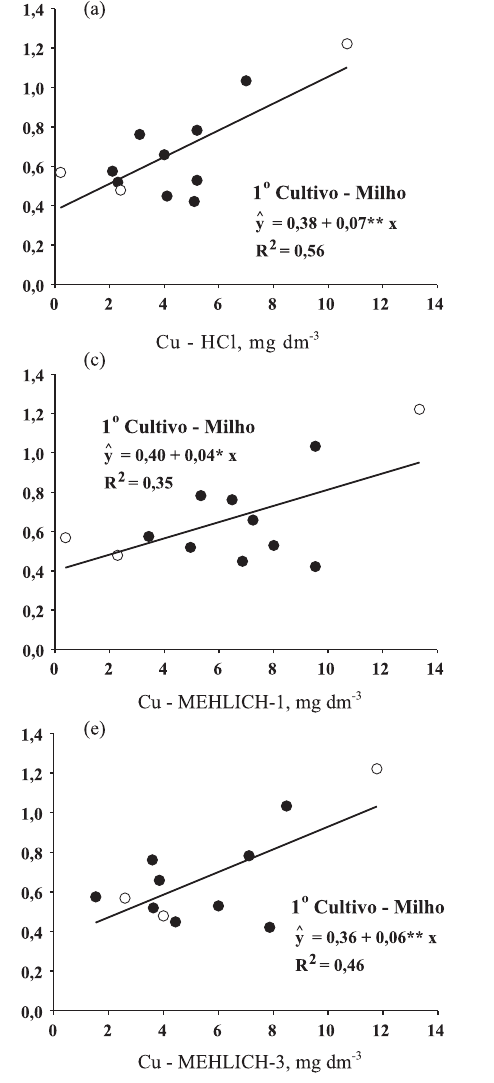
Figura 2. Relação entre os teores de cobre extraídos pelas soluções de HCl, Mehlich-1 e Mehlich-3, respectivamente, e a quantidade acumulada pelas plantas de milho [(a), (c) e (e)], no primeiro cultivo, e de soja [(b), (d) e (f)], no segundo